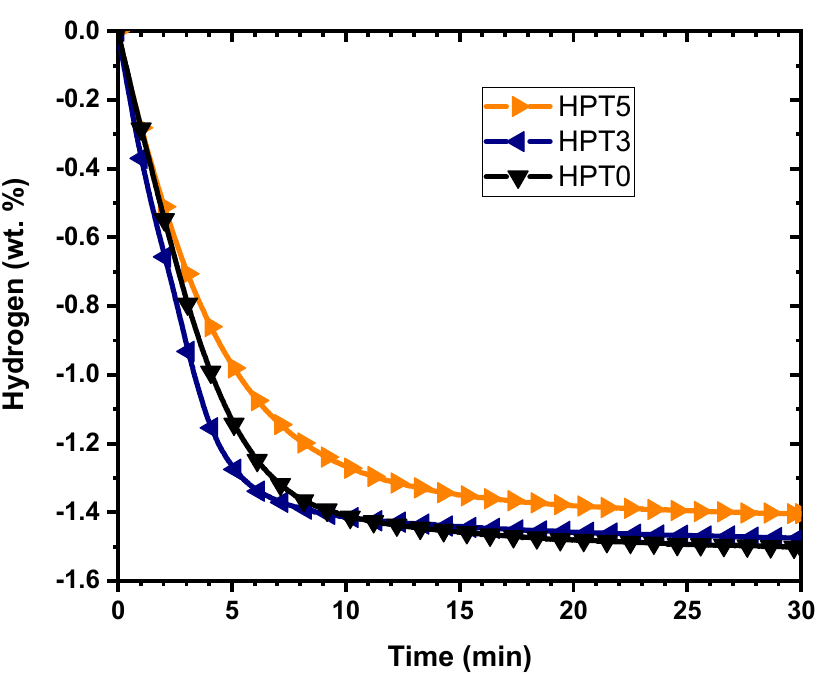
Figure 5. First dehydrogenation at room temperature under partial vacuum of HPT samples.